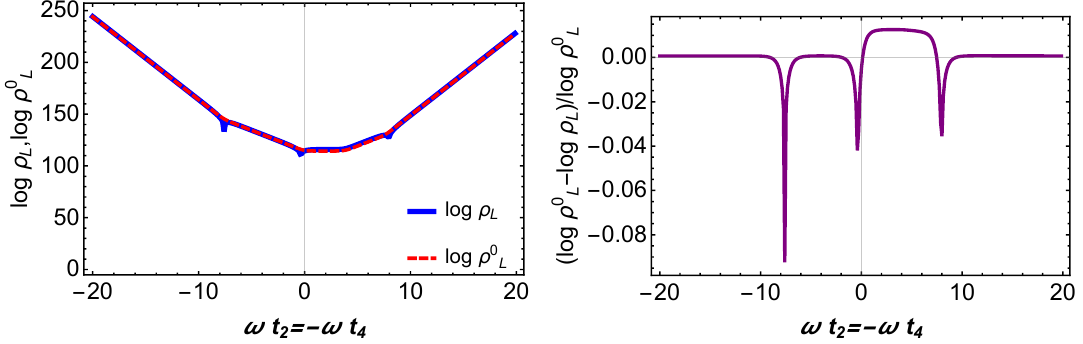
Figure 8 . log ρ vs time for the figure on the right. The parameters are set as ωt 1 = ωt 3 = 20 , δω